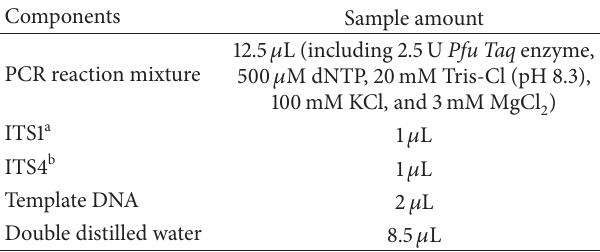
Table 1: Universal fungal primer PCR reaction